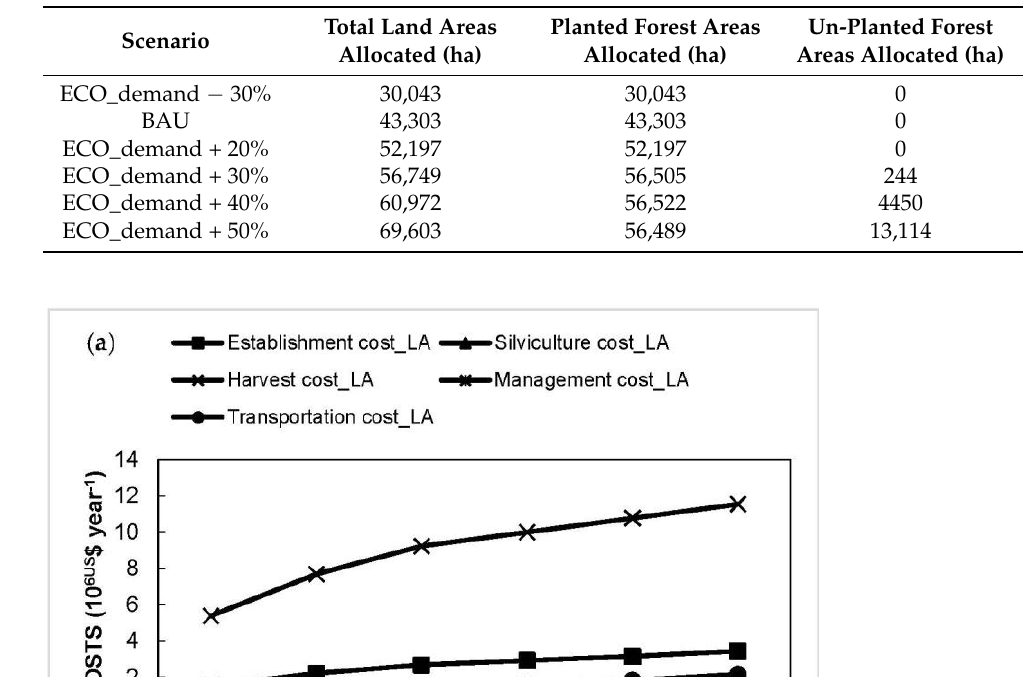
Table 5. Total forested area allocated for different timber demands under the current forest approach (_FO).